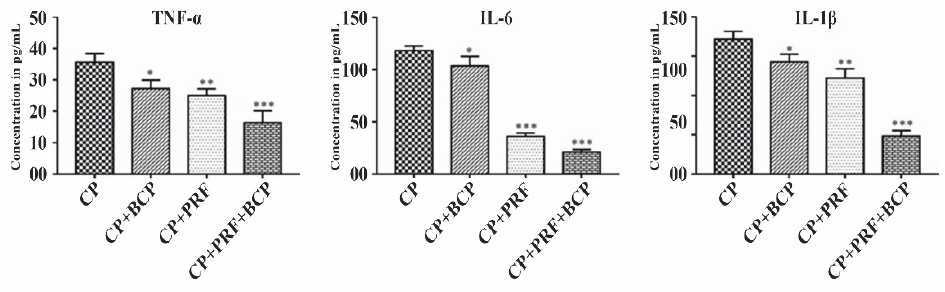
Figure 2. Effect of PRF/BCP on TNF- α , IL-6 and IL-1 β . Results are expressed as the mean ± SD. The comparisons were made among CP, CP + BCP, CP + PRF, and CP + PRF/BCP combination. (* p < 0.05; ** p < 0.01; *** p < 0.001).